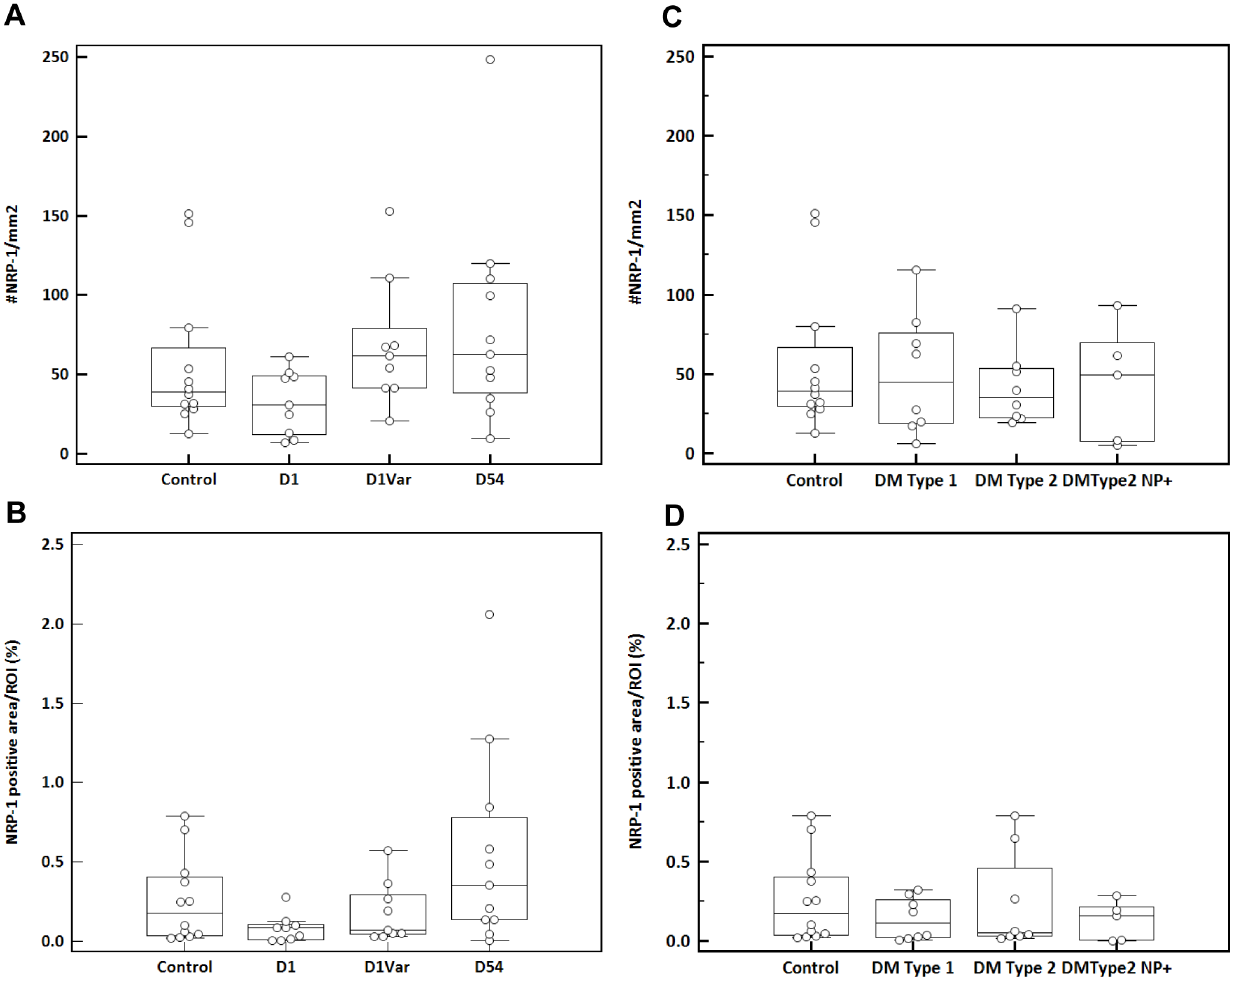
Fig 6. Definiens analysis of NRP-1 receptor expression in dermis. (A) Number of NRP-1 positive structures (#/mm 2 ) and (B) NRP-1 positive area/ROI (%) in dermis of controls, healthy volunteers who received topical capsaicin at day 1 (D1), variable time point (Dvar) and day 54 (D54) after capsaicin was applied. (C) Number of NRP-1 positive structures (#/mm 2 ) and (D) NRP-1 positive area/ROI (%) in dermis of controls, diabetic subjects Type 1 (DM Type 1), Type 2 (DM Type 2) and diabetic subjects suffering from polyneuropathy (DM Type 2